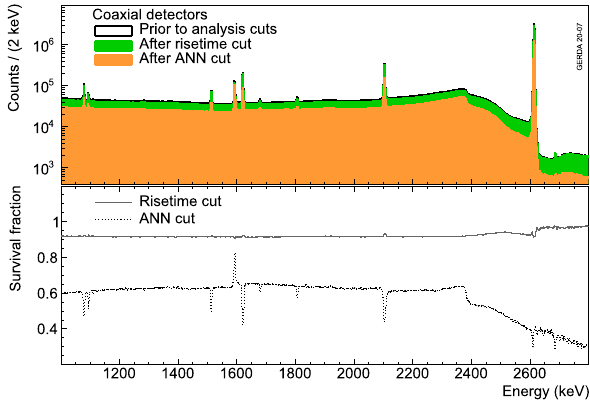
Fig. 14 Energydistributionsofcalibrationdataeventsfromthecoaxial detectors before and after the ANN and risetime cuts (top) and the corresponding survival fractions (bottom)